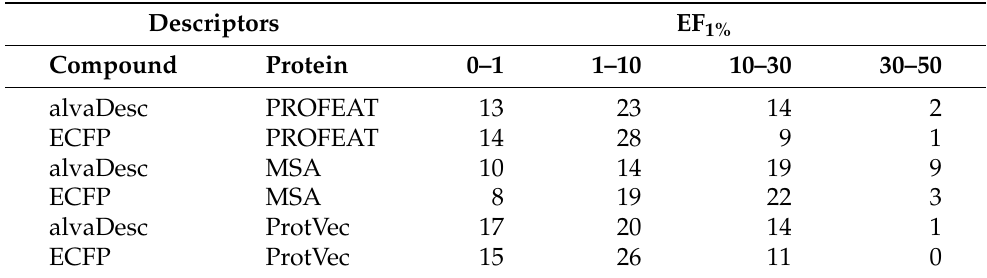
Table 3. Enrichment factor values and the number of GPCRs for each combination of descriptors. The compound and protein columns indicate the compound descriptor and protein descriptors used,